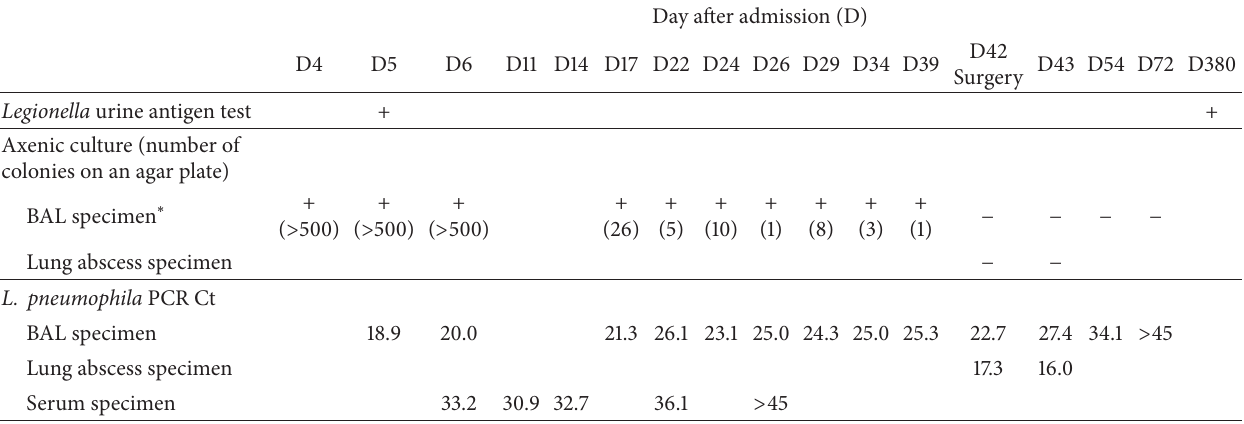
Table 1: Microbiological results for Legionella during the patient’s